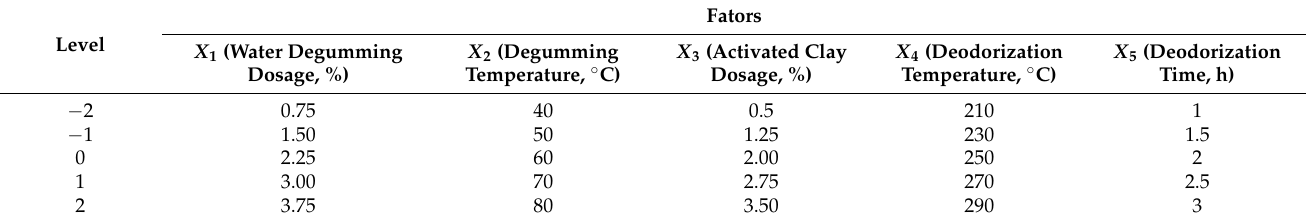
Table 1. The experimental design of five variable and five level RSM.